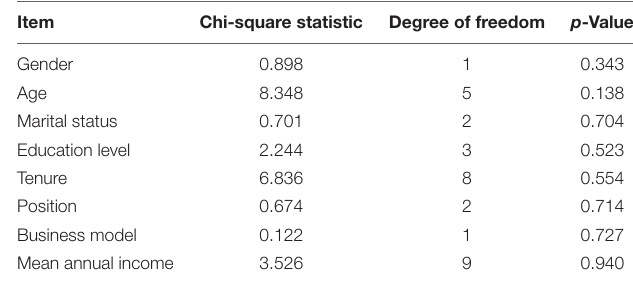
TABLE 1 | Results of the chi-square test for non-response